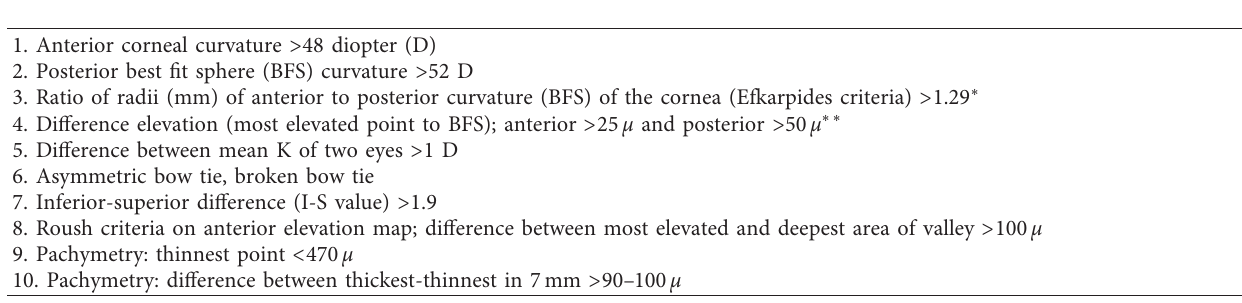
Table 1: Summary of the most important diagnostic criteria by Orbscan evaluation.